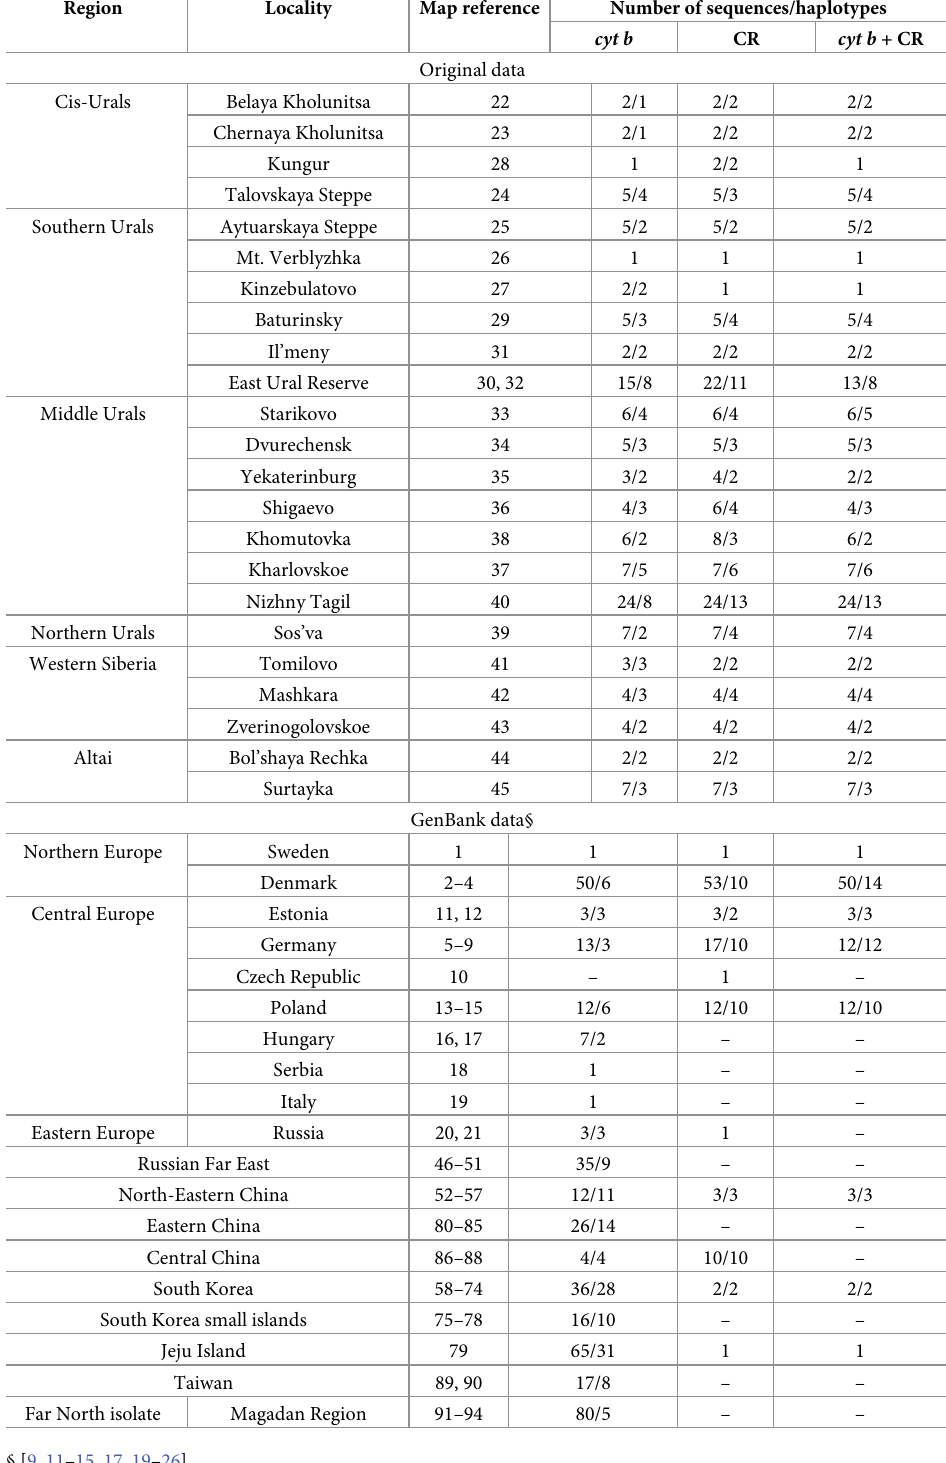
Table 1. A . agrarius samples analyzed in the study.